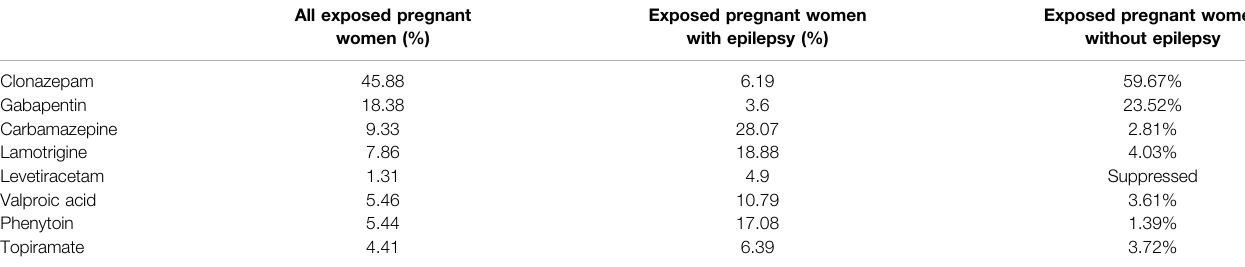
Values ≤ 5 were suppressed.